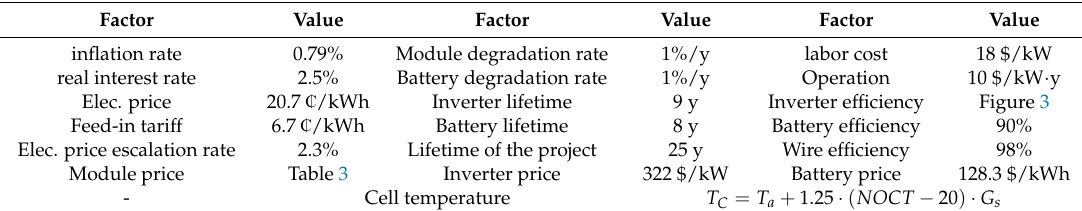
Table 2. Assumptions made in the present work.